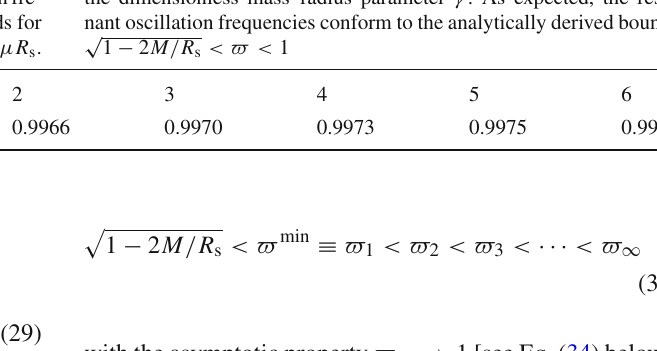
One finds that the characteristic resonant frequency (cid:16) min (γ) of the composed star–field system is a monotonically increasing function of the dimensionless mass–radius parameter γ . As expected, the